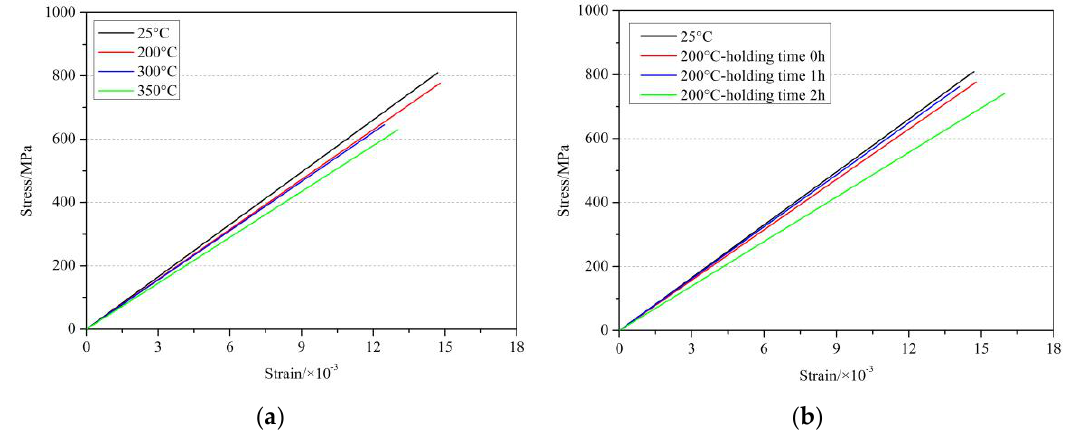
Figure 4. Stress-strain curve of GFRP bars after elevated temperatures exposure: ( a ) at holding time of 0 h; ( b ) at 200 °C.